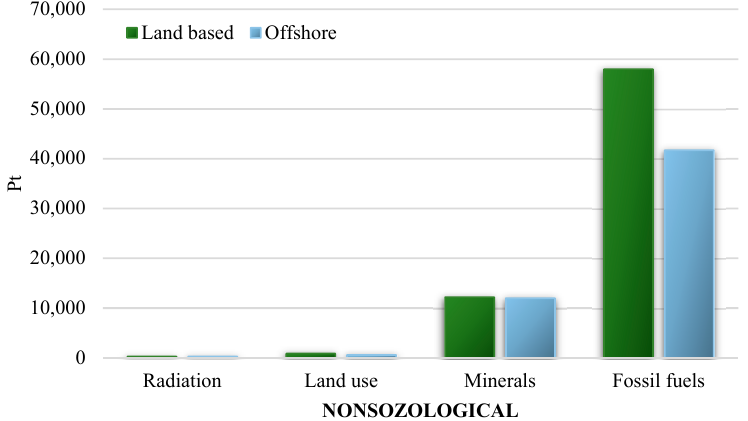
Figure 6. Results of grouping and weighing environmental impact for nonsozological impacts, occurring throughout land and offshore wind power plant life cycles. Authors’ own research.